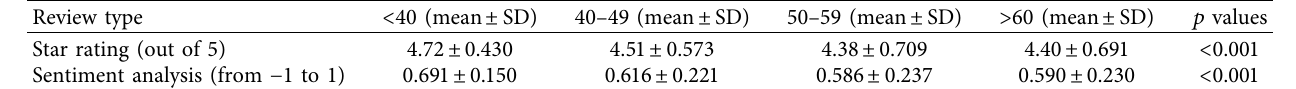
Table 3: Age analysis based on star rating and review sentiment analysis.